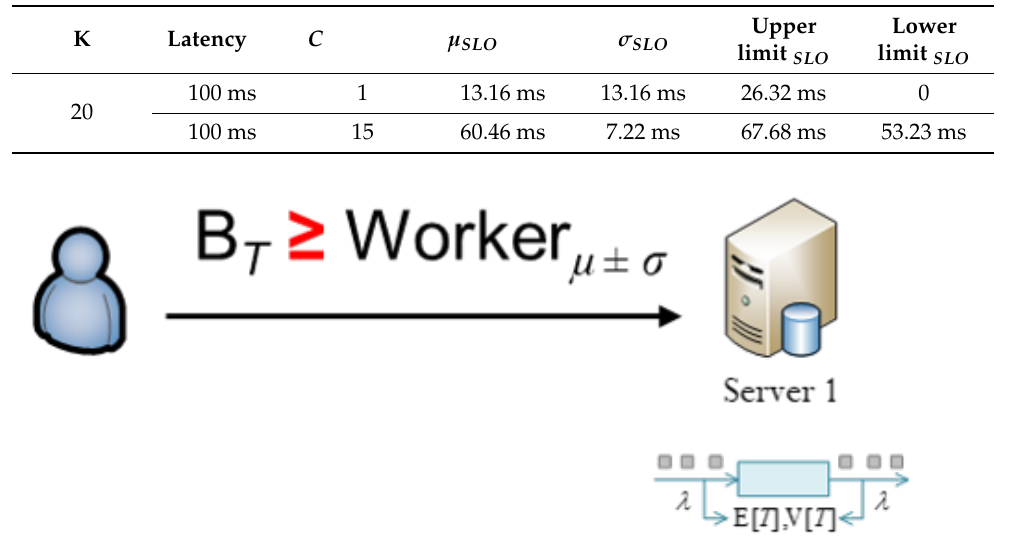
Table 5. Translated budget using two different C ratios.